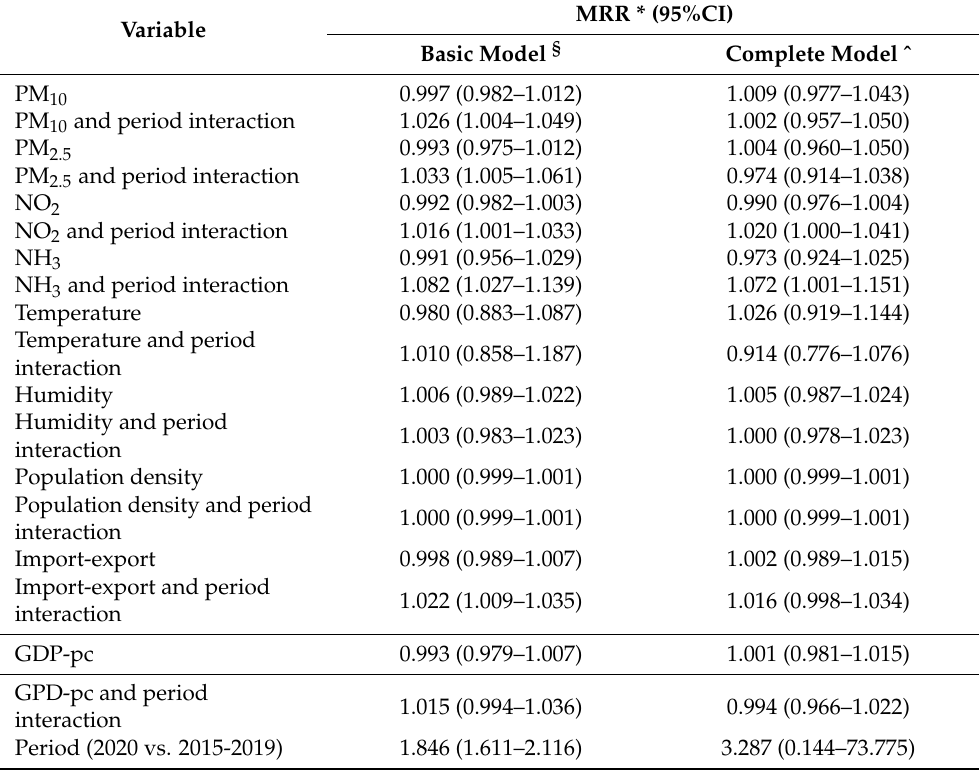
Table 3. Mortality rate ratios (MRRs) * with 95% confidence intervals (CI). Analyses restricted to the 39 Italian provinces for whichPM 2.5 data were